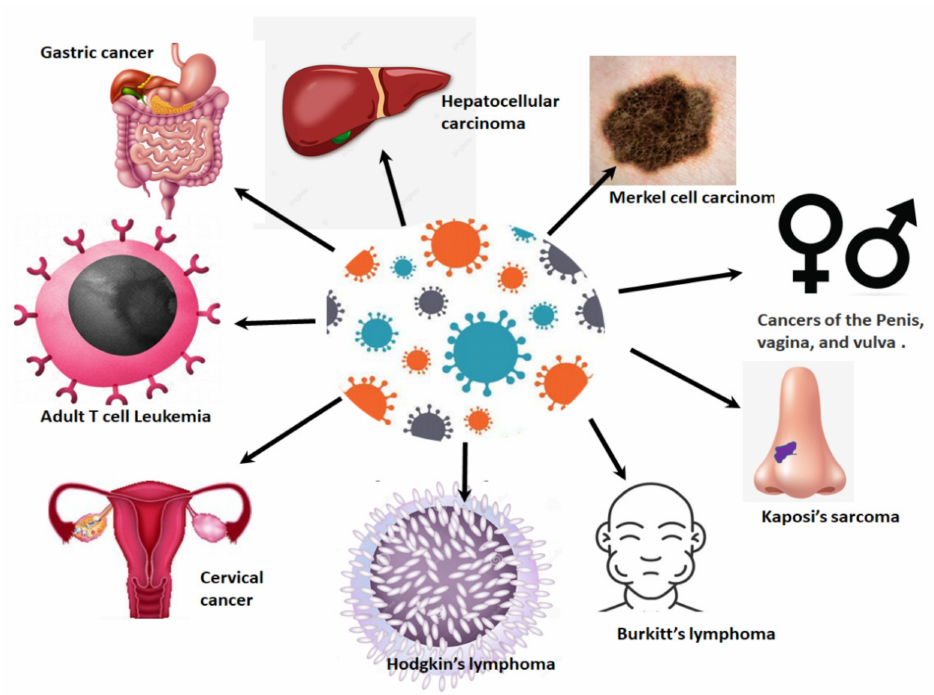
Figure 1. Viral-associated cancers: infections with viruses such as Epstein–Barr virus, HPV, hepatitis B virus, hepatitis C virus, human herpes virus, human T cell leukemia virus and HIV can lead to the development of a variety of